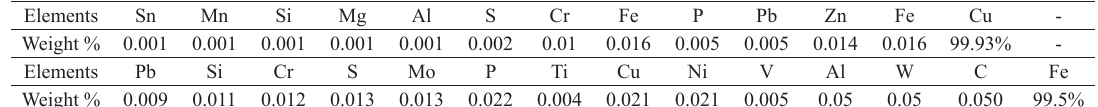
Table 1. Evaluation of base metal (BM) alloy composition (expressed in wt.%) of the copper and steel plate used at the present work. Elements